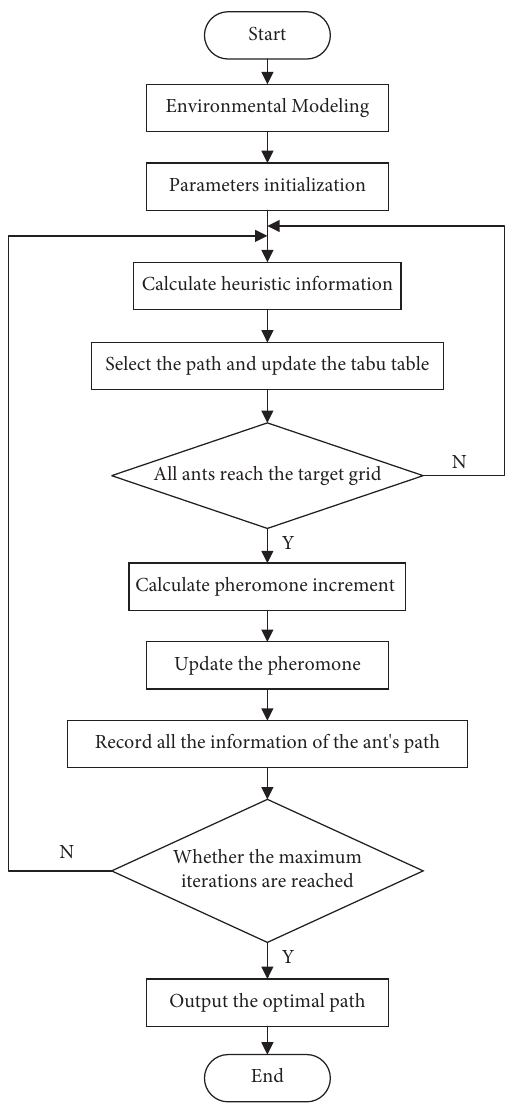
Figure 3: Flowchart of improved ant colony algorithm path